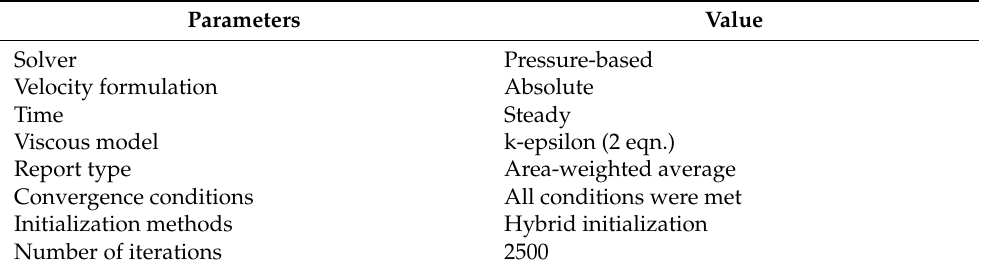
Table 4. General CFD parameters.